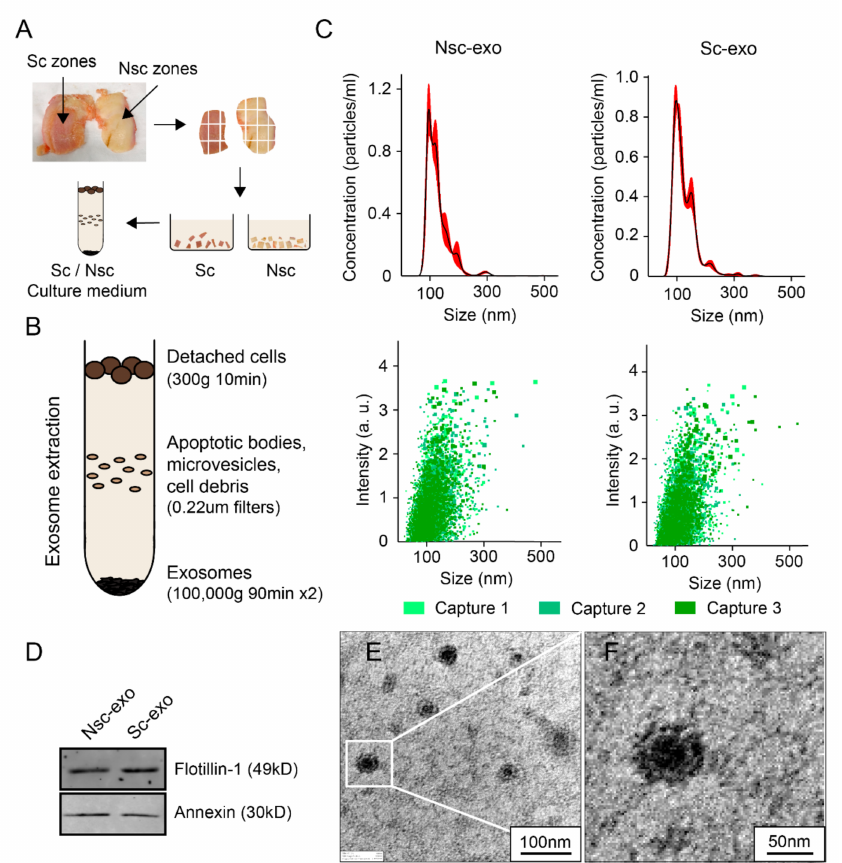
Figure 1. Methods and characterization of exosomes extracted from Nsc-SBOs and Sc-SBOs. ( A , B ) Exosomes were isolated from culture medium of Nsc-SBOs and Sc-SBOs. ( C ) Exosome size and concentration was measured using NS300 NanoSight (n = 3 patients). ( D ) Western blotting analysis of exosomal markers in Nsc-SBOs and Sc-SBOs exosomes (images representative of n = 3 patients). ( E , F ) TEM images of purified exosomes derived from SBOs. The images are representative of exosomes isolated from three different patients. Nsc, nonsclerotic; Sc, sclerotic; SBOs, subchondral bone osteoblasts; Nsc-exo, nonsclerotic SBO derived exosomes; Sc-exo, sclerotic SBO derived